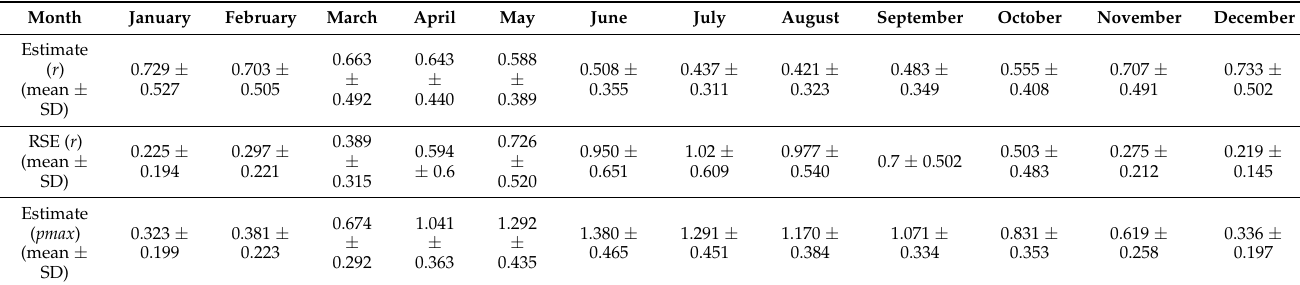
Table 2. Estimates and residual standard errors in the estimation of r (mg O l − 1 h − 1 ) and estimates of pmax (mg O l − 1 h − 1 ). Values reported are monthly means for all water bodies and years pooled ± the standard